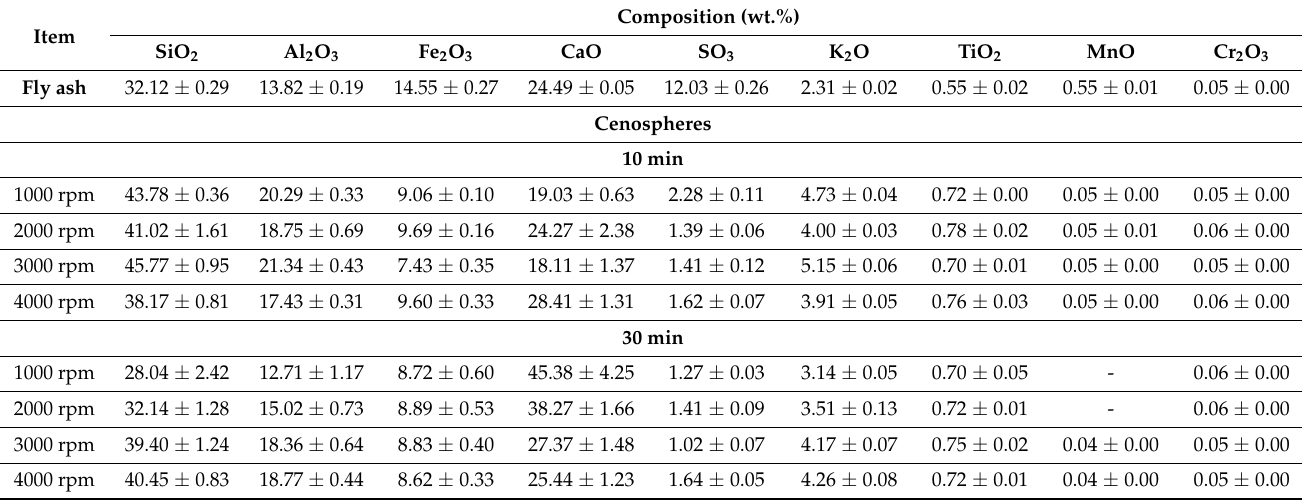
Table 1. Chemical compositions characterized by XRF of the cenospheres collected by centrifugal method using the centrifugal speeds of 1000, 2000, 3000, and 4000 rpm, and the centrifugal times of 10 min and 30 min. Composition (Wt.%) Item